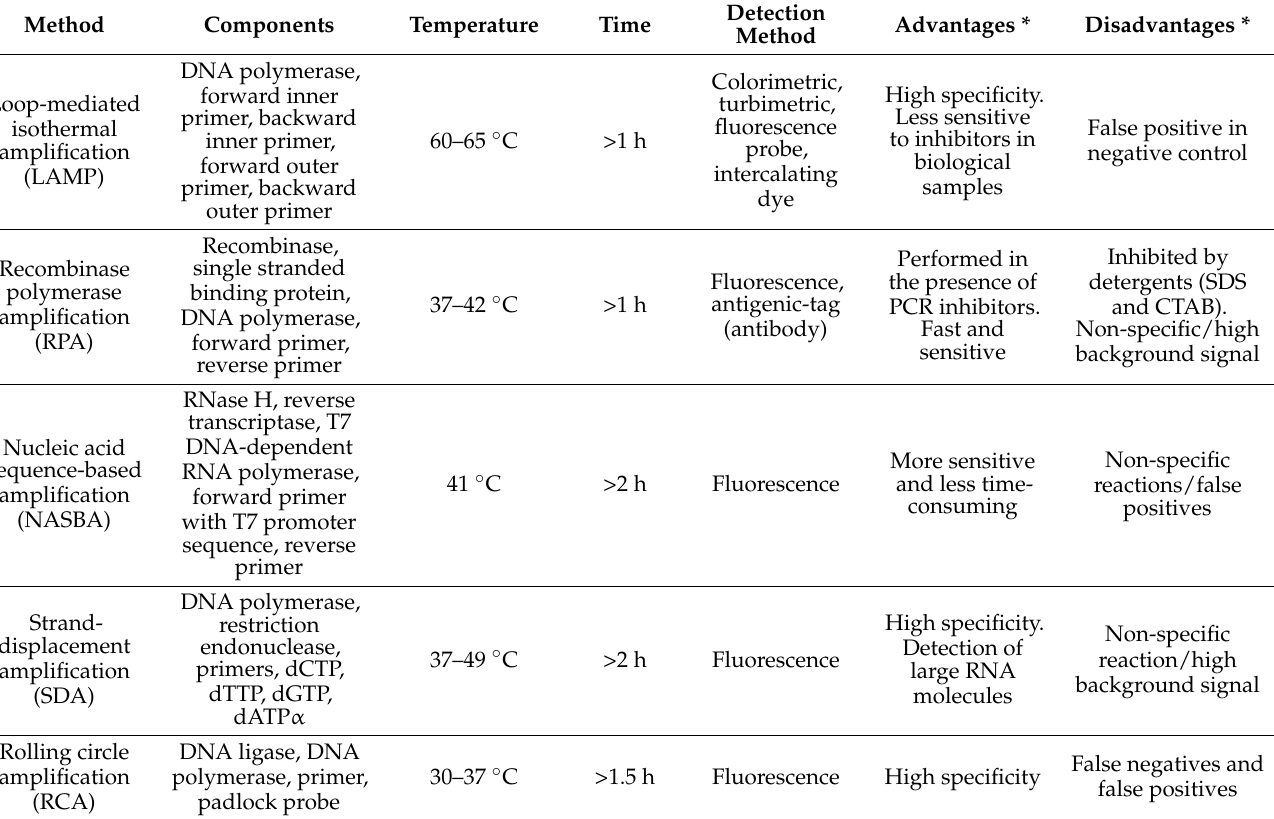
Table 3. General features of the isothermal amplification techniques for SARS-CoV-2